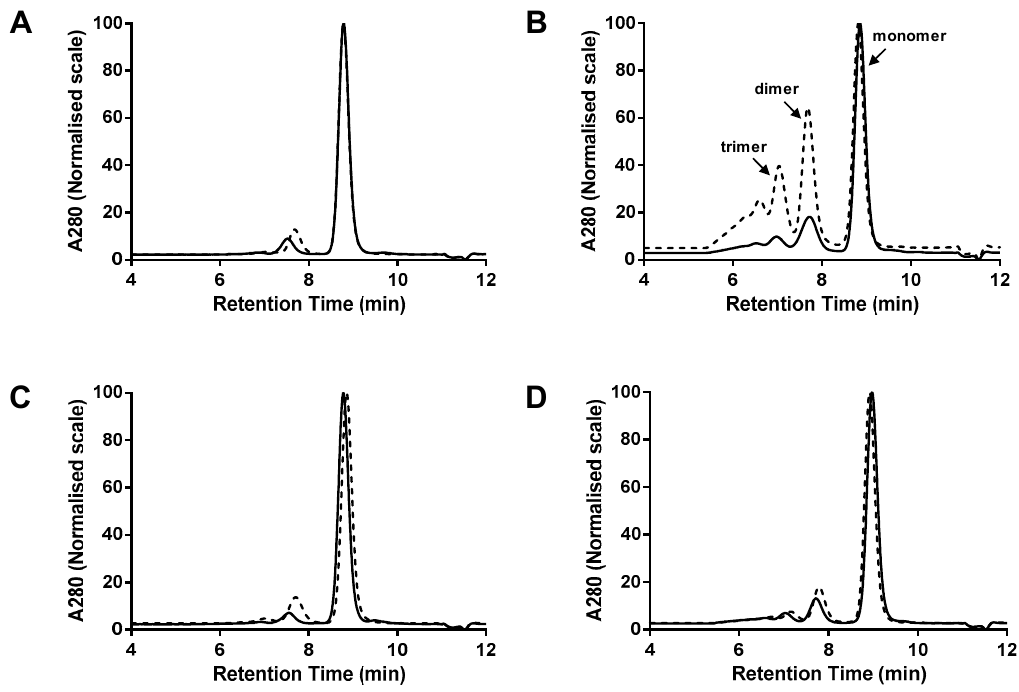
Figure 3. Multimerisation of Fab-dsFv vs. Fab-dsscFv. G3000 SEC analysis of proteins purified by Protein G HPLC from 293F cells – representative data from one of three independent experiments are shown. ( A ) Fab-dsFv/dsscFv#1; ( B ) Fab-dsFv/dsscFv#2; ( C ) Fab-dsFv/dsscFv#3; ( D ) Fab-dsFv/dsscFv#4. Dashed lines represent Fab-dsFv; continuous lines denote Fab-dsscFv. Peak heights are normalised to 100%. Gel filtration protein standards (BioRad) were loaded for molecular weight estimation.